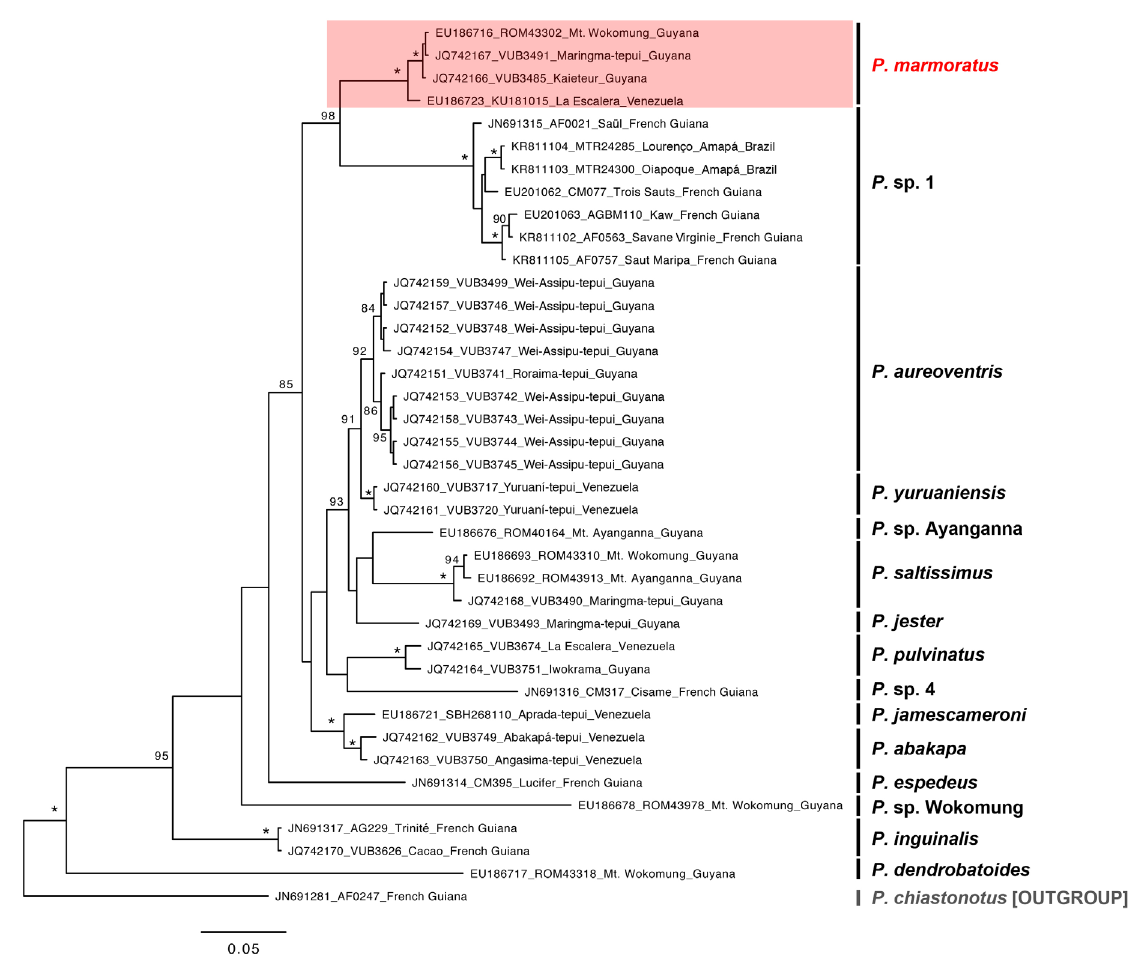
Fig. 10. Phylogenetic relationships within the Pristimantis “ unistrigatus group” in the Guiana Shield as recovered in the MrBayes analysis (438 bp of the 16S rRNA gene sequence). Values at each node represent statistical support (* = 0.99 or 1). Pristimantis marmoratus (Boulenger, 1900) is highlighted in